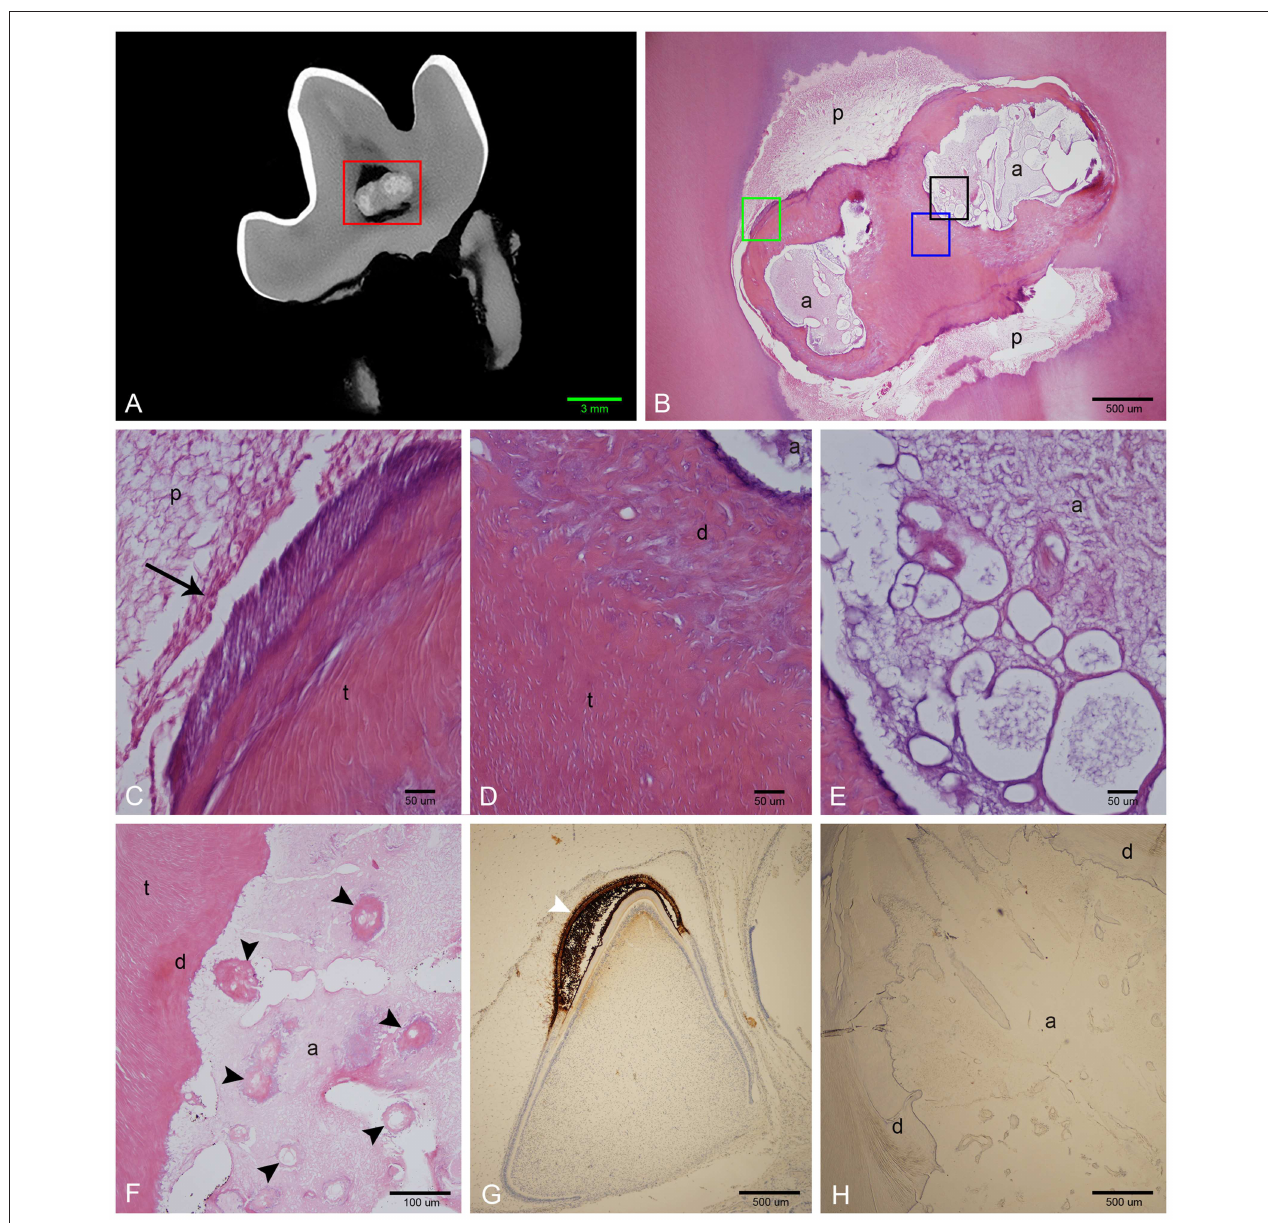
FIGURE 6 | Histological features of affected teeth on decalcified sections. (A) Sagittal micro-CT of the right mandibular first molar tooth from dog 3. (B) Low magnification H&E stain of a section approximating the area marked by the red rectangle in (A) . The abnormal tissue is composed of small amounts of acellular eosinophilic matrix, yet corresponding areas on the micro-CT image are relatively highly attenuating, indicating that the bulk of material has been lost during decalcification. (C) High magnification of area denoted by green rectangle in (B) . Vital pulp lined with odontoblasts (black arrow). (D) High magnification of area denoted by blue rectangle in (B) . Disorganized dentin lines the abnormal tissue, transitioning to tubular dentin further away. (E) High magnification of area denoted by black rectangle in (B) , showing detail of acellular matrix with basophilic staining at the periphery. (F) High magnification of an area of abnormal tissue from the left mandibular first molar tooth from dog 1. Multiple islands of hypereosinophilic material resembling dentin with central channels can be seen (black arrowheads) within the mostly eosinophilic acellular matrix. (G) Low magnification of positive control slide (tooth germ of a full-term canine fetus) treated with anti-amelogenin antibody showing strong positive reaction in the enamel layer of a developing tooth germ in bell stage (white arrowhead). (H) Low magnification of a transverse section of the left mandibular first molar tooth in dog 1 stained with anti-amelogenin antibody, showing no positive reaction. a, abnormal tissue; d, disorganized dentin; t, tubular dentin; p,